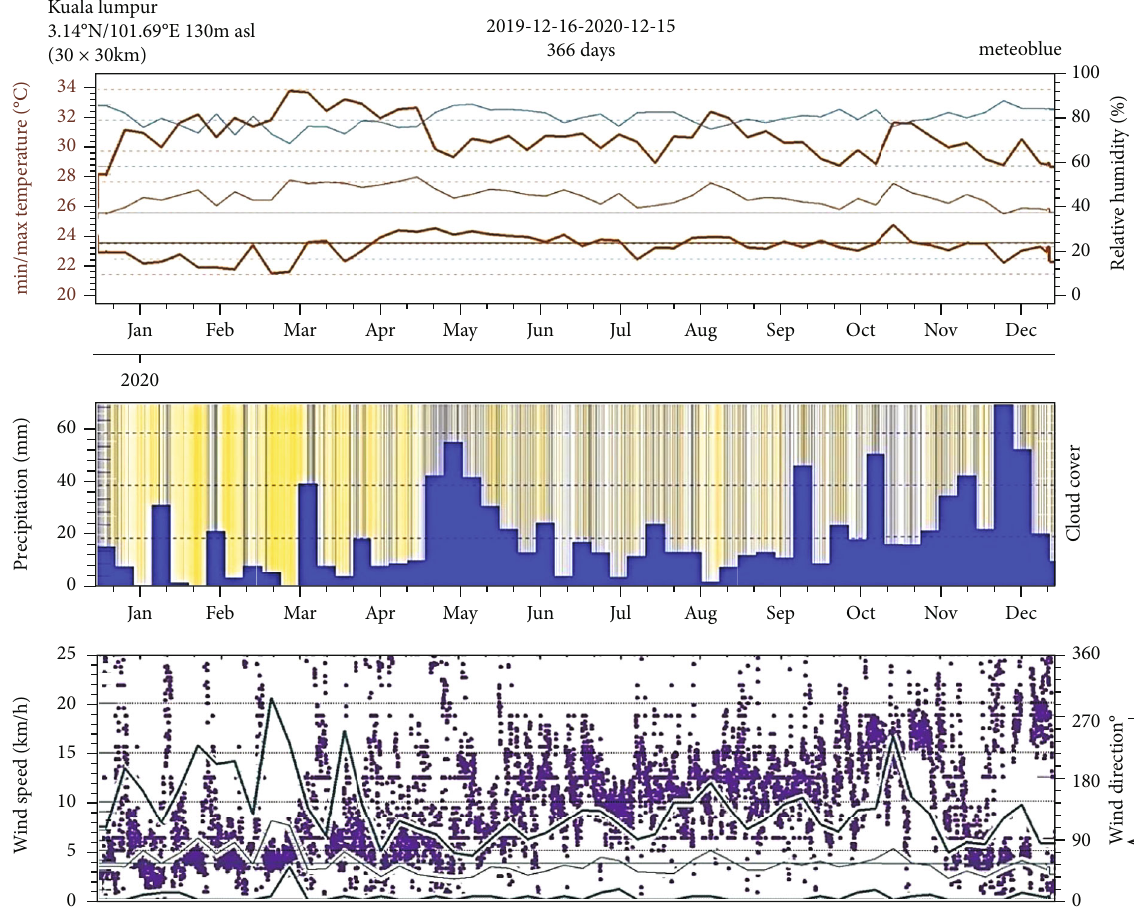
Figure 5: One-year weather data of Kuala Lumpur [33].